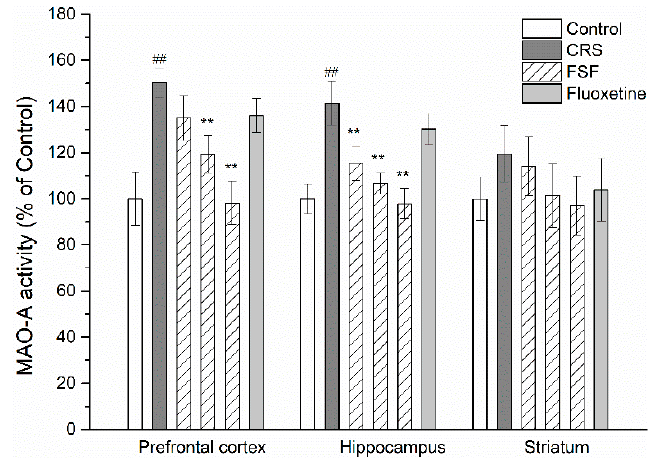
Figure 9. Effects of FSF on enzyme activities in the prefrontal cortex, hippocampus and striatum in mice. n = 6, ## p < 0.01, vs. control group; ** p < 0.01, vs. CRS group.